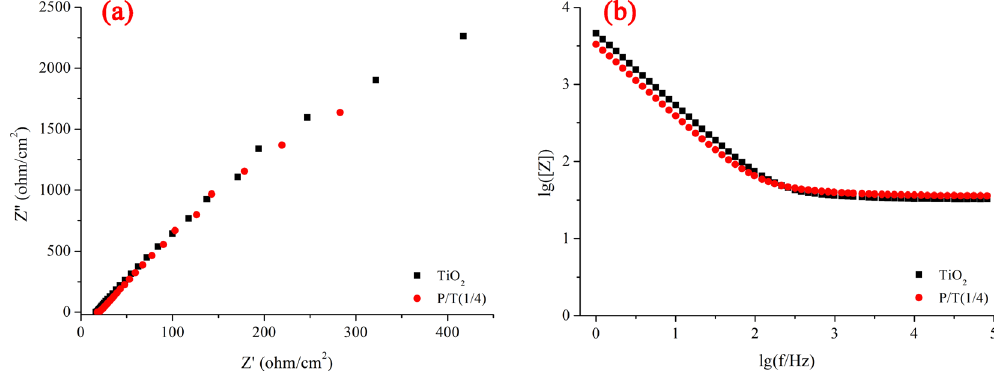
Figure 13. Electrochemical impedance spectroscopy of samples. (a and b represent the Nyquist plot and Bode plot,